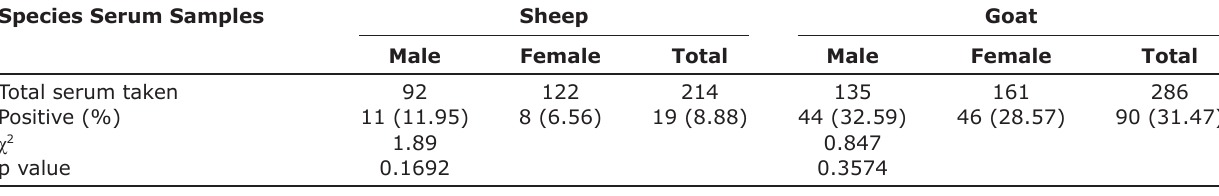
Table-1: Seroprevalence of Capripoxvirus infection in sheep and goats (overall and based on sex). Species Serum Samples Sheep